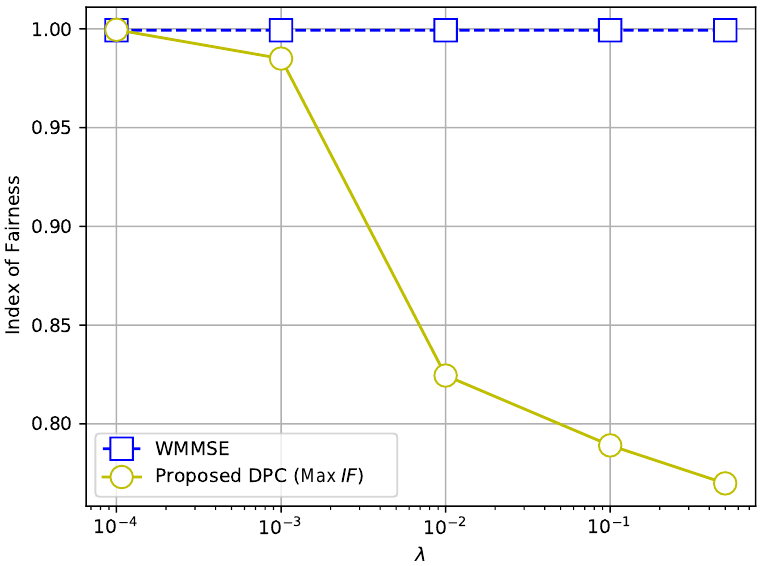
Figure 6. Index of fairness of the proposed deep power control (DPC) scheme according to λ in the loss function under Rayleigh fading channels.